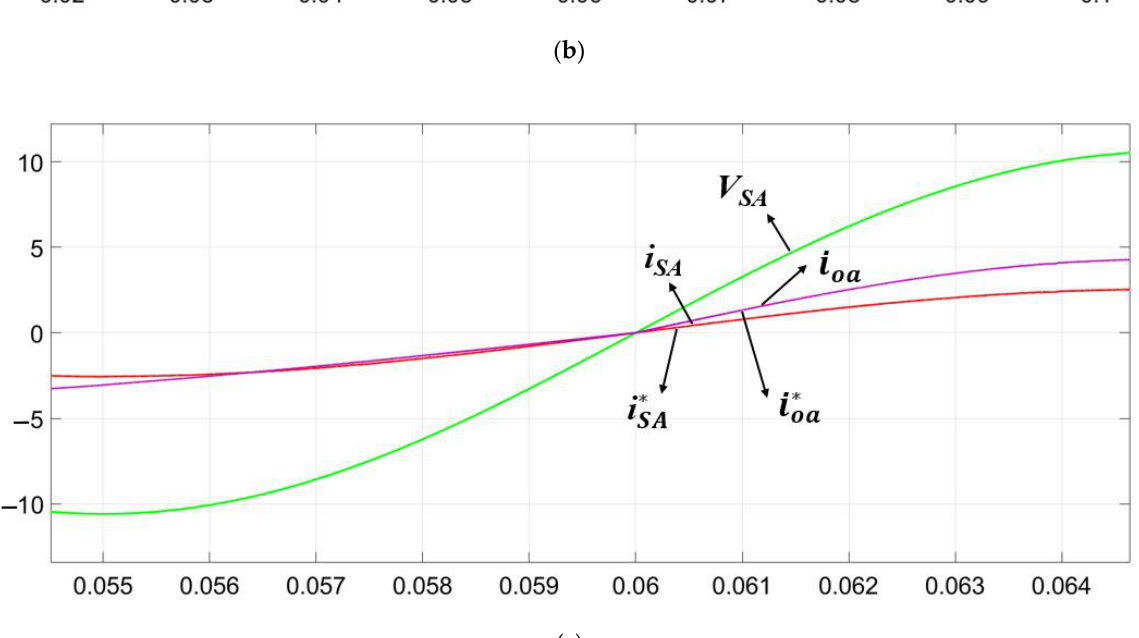
Figure 9. Simulation results of the VMMPC for the TSMC, where output-current frequency reference steps from 25 Hz to 50 Hz at t = 0.06 s, source voltage V sA /13 V, source-current reference i sA * A, source current i sA A, output current i oa A, and output-current reference i oa * A, x-axis unit second: ( a ) without the IFRS; ( b ) with the IFRS; ( c ) details of the box in Figure 9b.